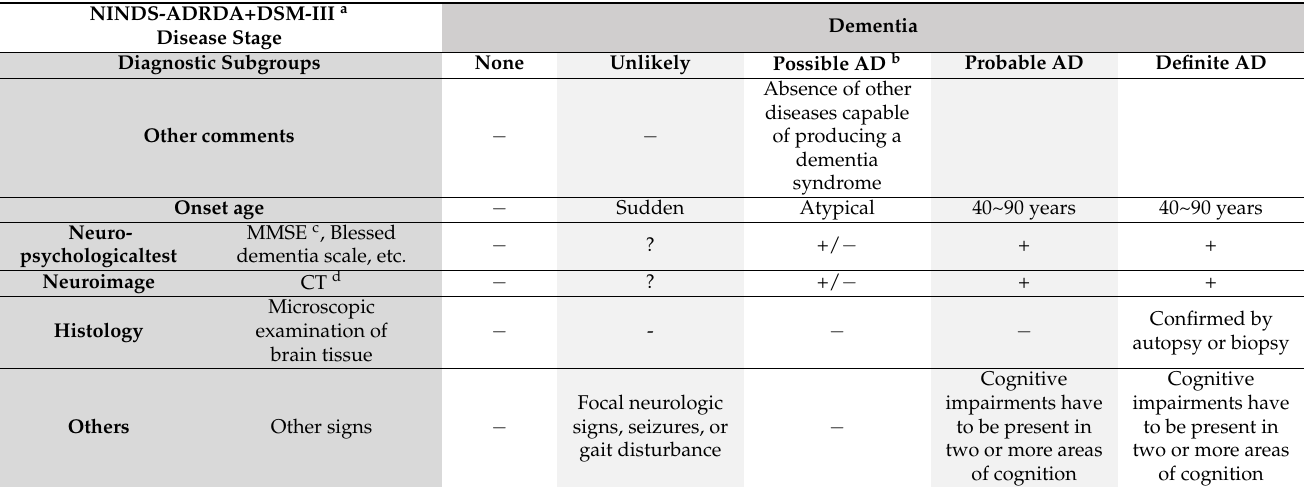
Table 1. Clinical Alzheimer’s disease